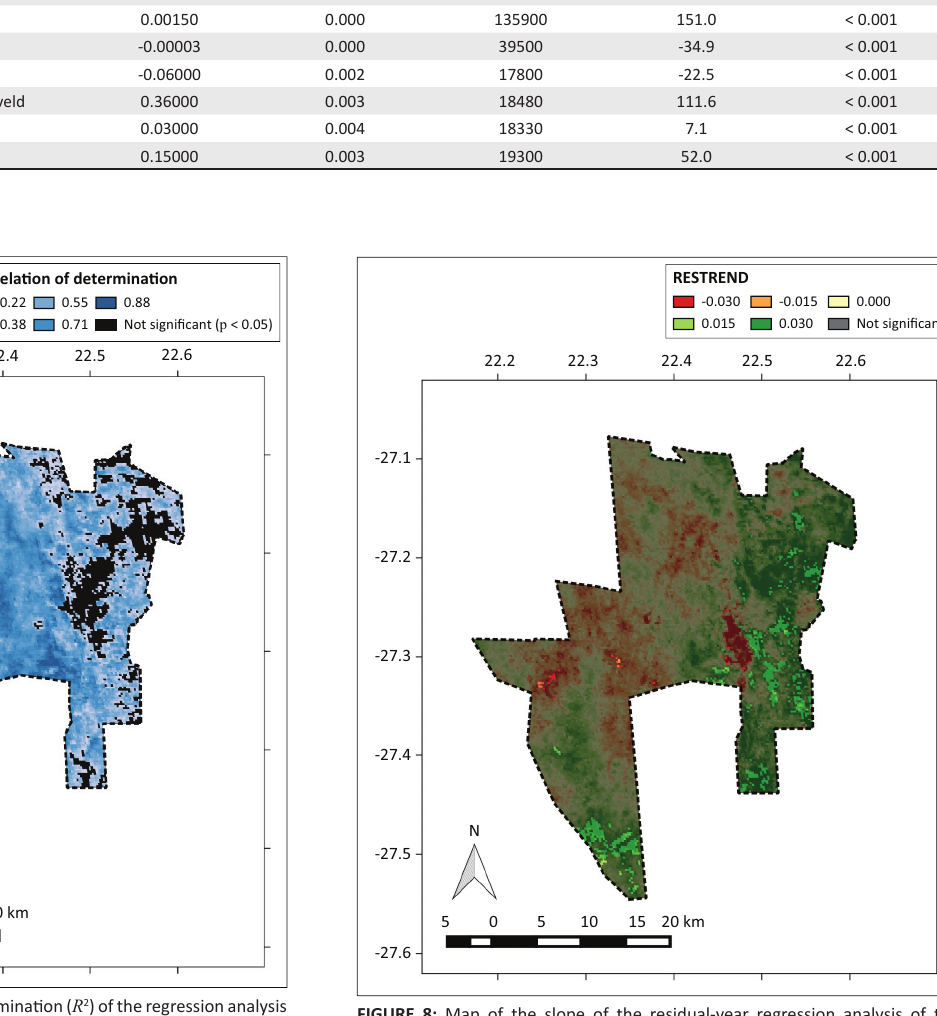
FIGURE 8: Map of the slope of the residual-year regression analysis of the residual trend analysis. The areas where a significant trend was not found are displayed in grey. The residual trend analysis showed a significant positive long- term trend in vegetation productivity in the eastern and south-western parts of the Tswalu Kalahari